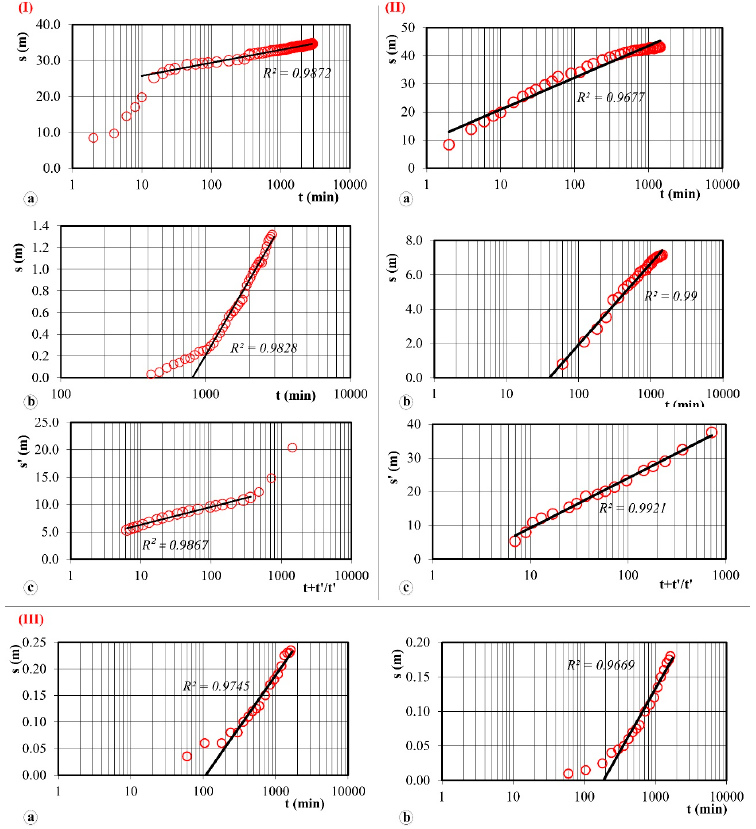
Figure 5. Interpretation of pumping tests. ( I ) 110_02, Cooper–Jacob method: ( a ) Pumping period data for 110_02; ( b ) Pumping period data for the observation well 110_03, located 370 m from 110_02; ( c ) Theis recovery method; ( II ) 122_09, Cooper–Jacob method: ( a ) Pumping period data for 122_09; ( b ) Pumping period data for the observation well 122_07, located 128 m from 122_09; ( c ) Theis recovery method. ( III) 122_23, Cooper–Jacob method for two observation wells: ( a ) Located 16 m ( b ) Located 63 m